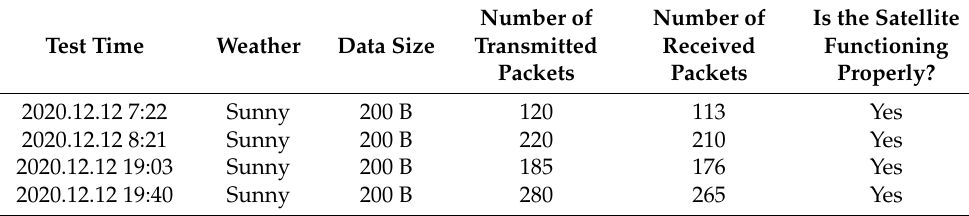
Table 6. Throughput (without the packet creation mode).